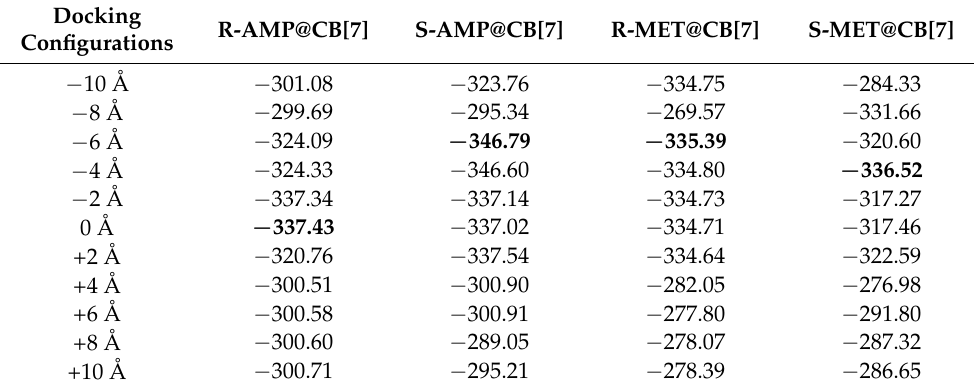
Table 1. Calculated complexation energies (in kJ/mol) of CB[7] with R-AMP, S-AMP, R-MET and S-MET at BLYP-D4/def2-SVP-gCP level. Docking Configurations